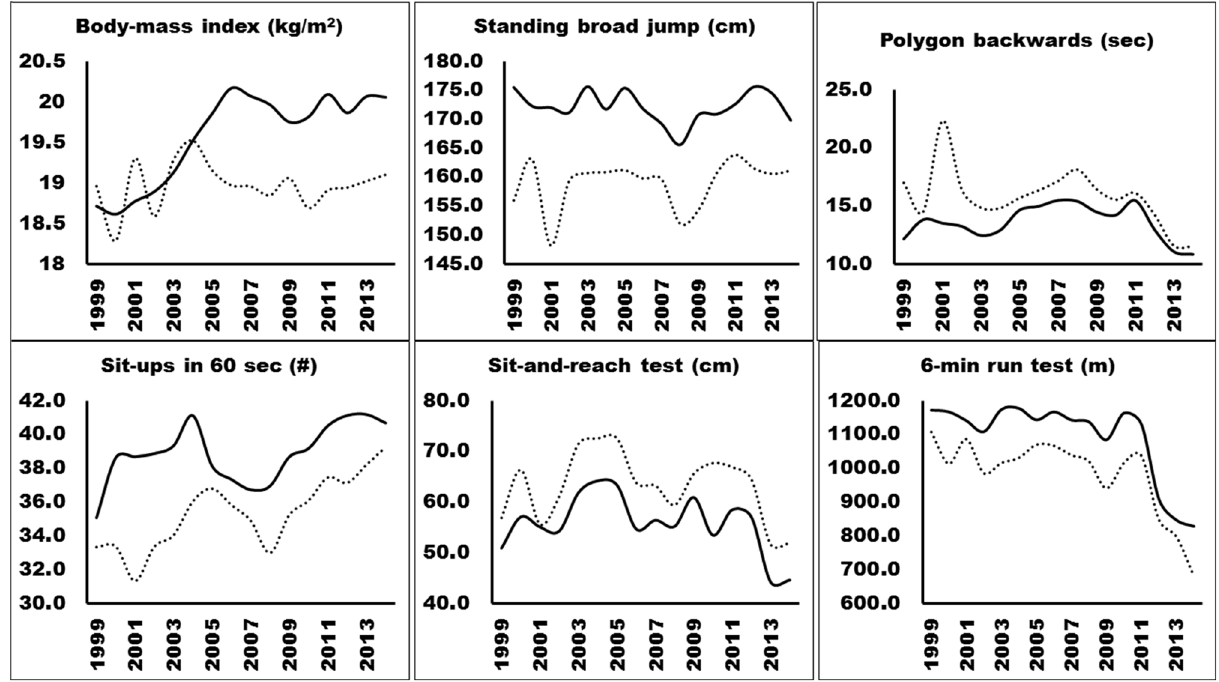
Figure 1. Secular trends of in health-related physical fitness among 11 to 14-year-old boys (black full line) and girls (discontinuous line) from 1999 to